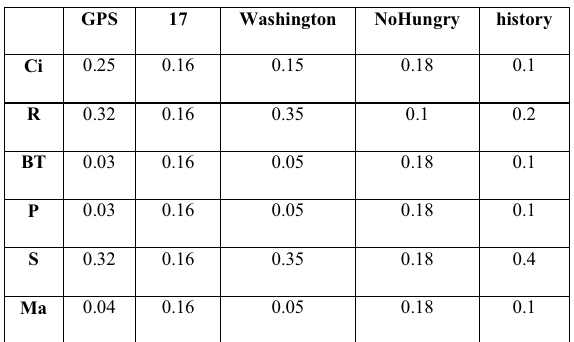
Table 3. Likelihood probabilities of concepts {city